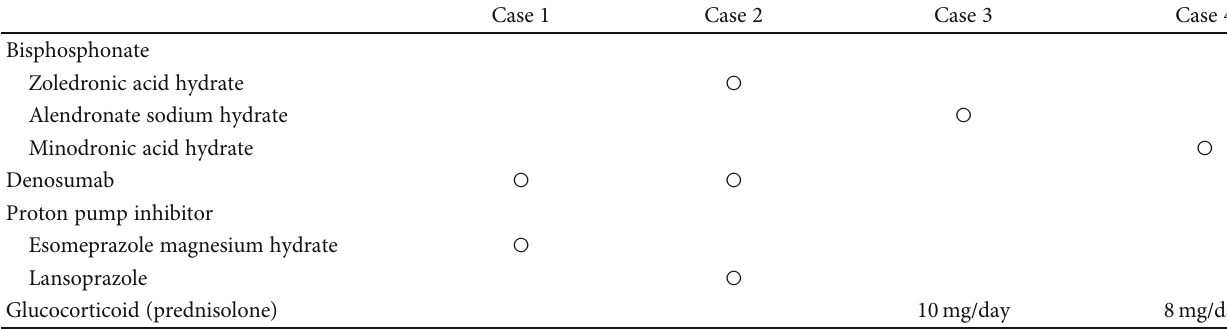
Table 1: Medication history of each patient.